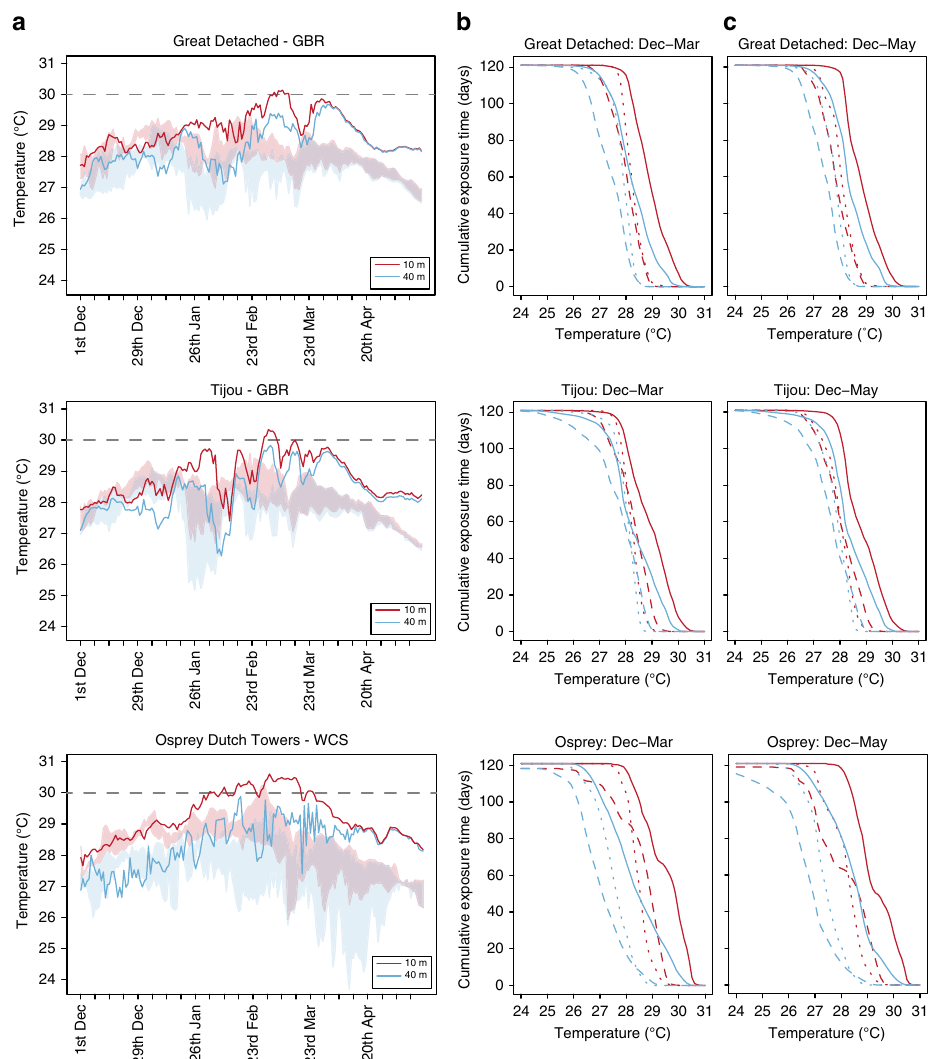
Fig. 3 Temperature pro fi les during the 2016 bleaching event compared with the three previous years. a Daily average temperatures at 10 and 40 m during the warmest months in 2016, compared with the daily minimum and maximum temperatures recorded in the three previous years (indicated with shading). b Cumulative exposure times (days) and temperatures (0.1 °C) shown for three consecutive 1 December – 31 March periods. c Cumulative exposure times (days) and temperatures (0.1 °C) shown for three consecutive 1 December – 17 May periods. Dotted lines refer to 2013 – 2014, dashed lines to 2014 – 2015 and solid lines to 2015